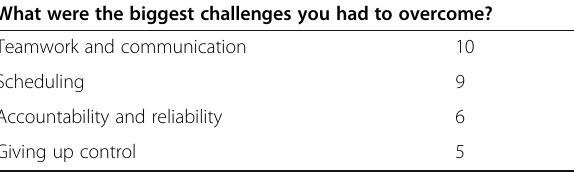
Table 4 List of challenges that students described in their